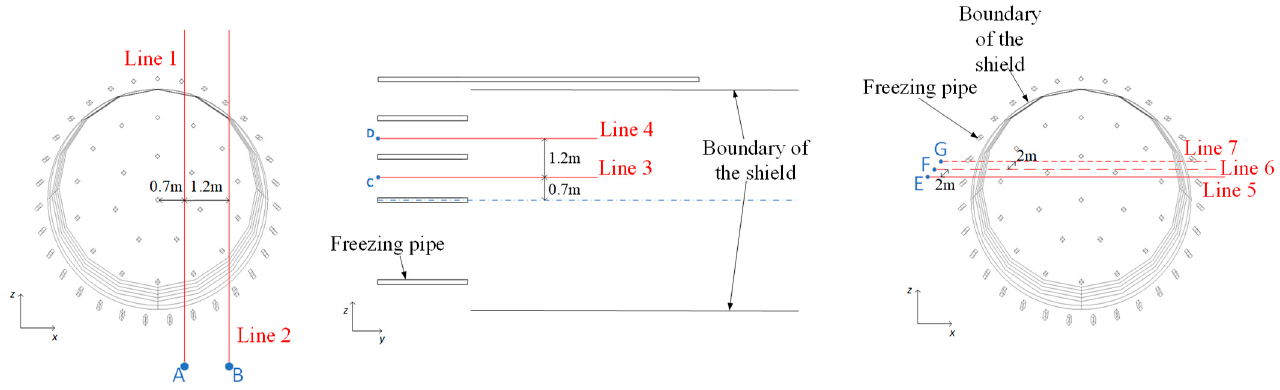
Figure 7. Location of critical numerical reference lines.